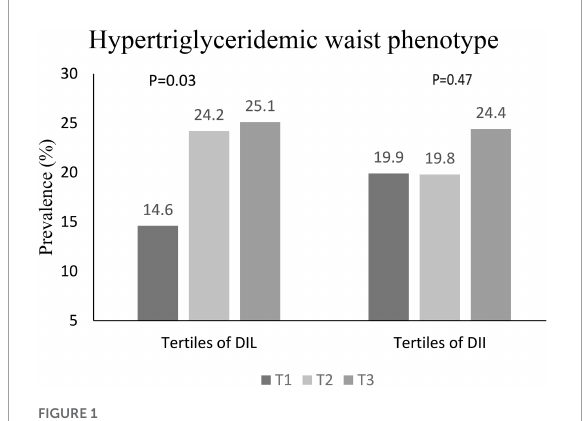
FIGURE1 Prevalence of HTGW phenotype in tertiles of DIL and